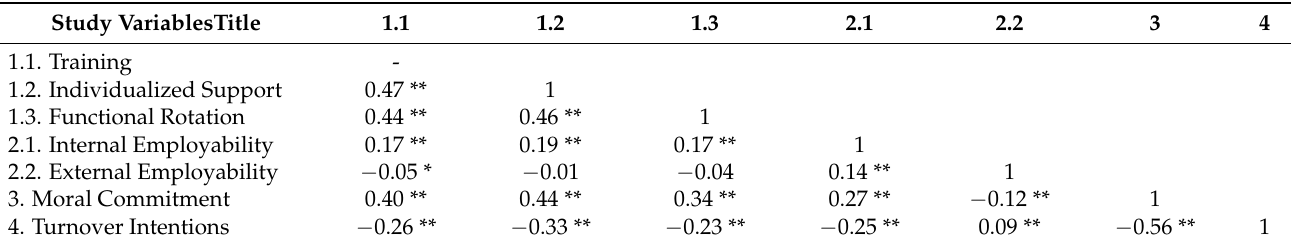
Table 1. Pearson Correlation Matrix.